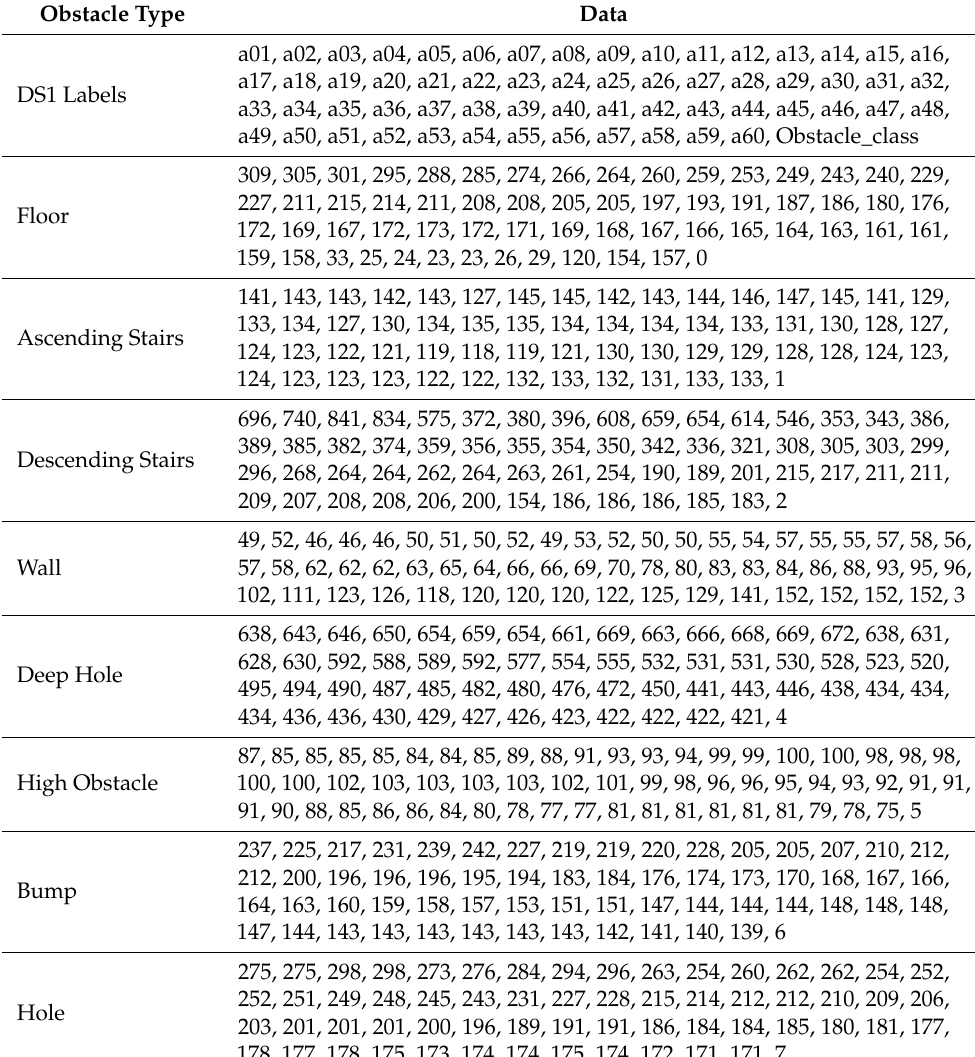
Table 5. Dataset 1 (D1)